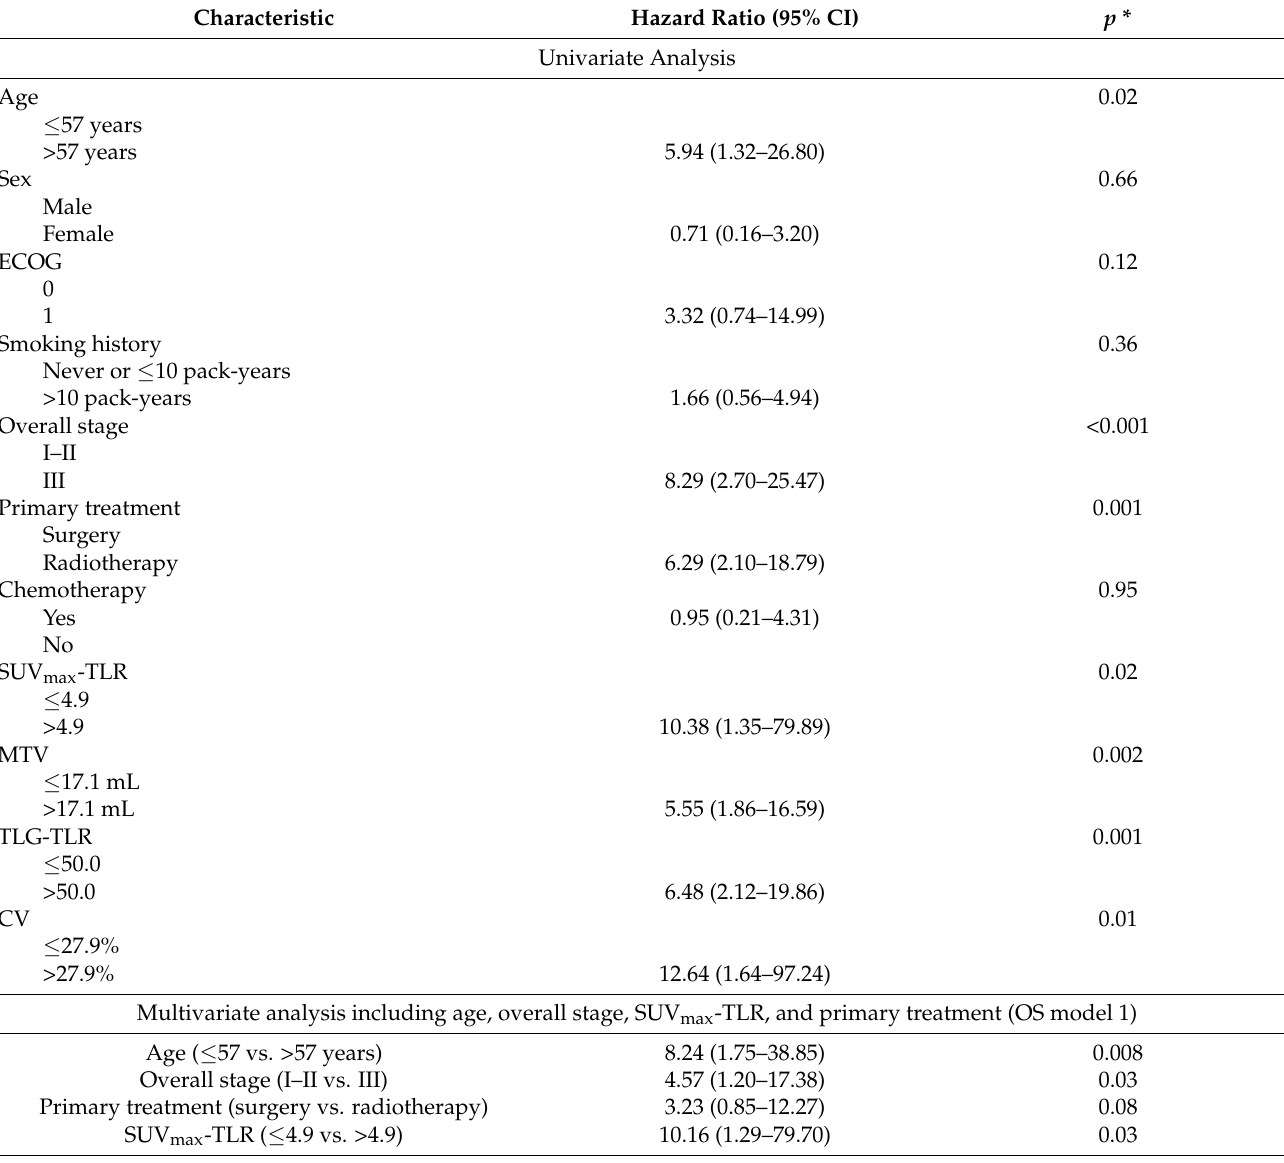
Table 3. Univariate and multivariate analyses for overall